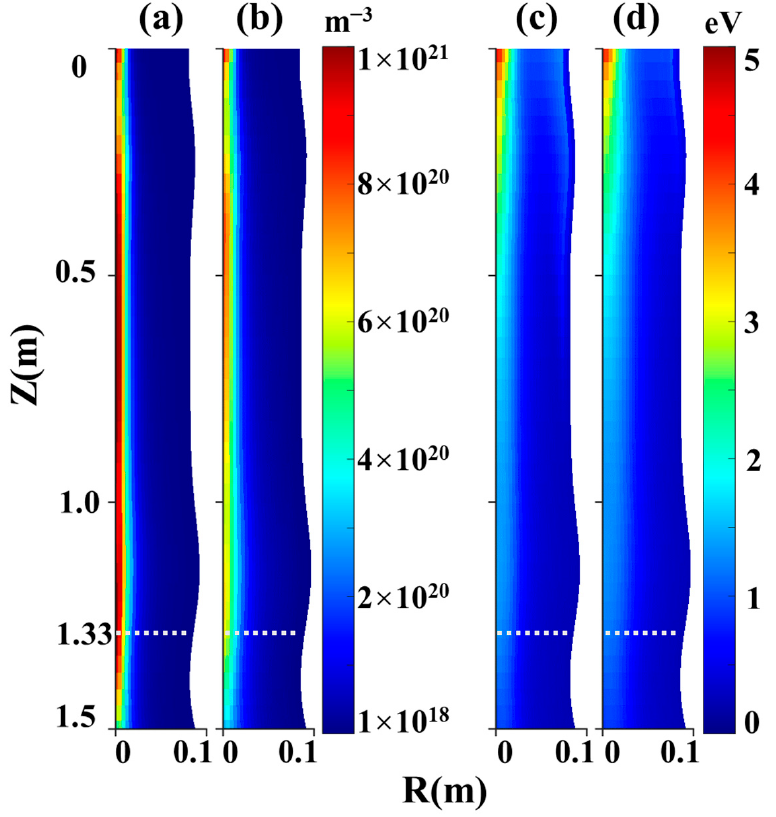
Figure 16. Simulation results of 2D distributions of electron density of Case 1 ( a ) and Case 2 ( b ), and electron temperature of Case 1 ( c ) and Case 2 ( d ). The source position in Figure 14 corresponds to Z = 0 .